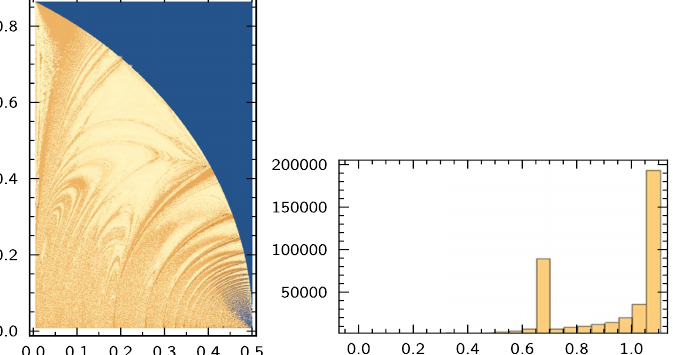
Fig. 7. Left: maximum values of Shannon entropy for Method bin; right: histogram of maximum entropy